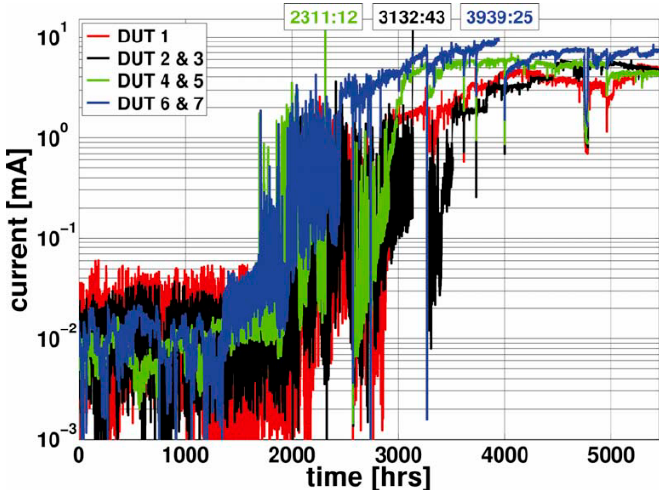
Figure 3. Example of an HV-THB test monitoring for 1.2 kV devices tested at 65% V nom . Failure timestamps are reported at the top of the picture. Figure reproduced with permission from [9].